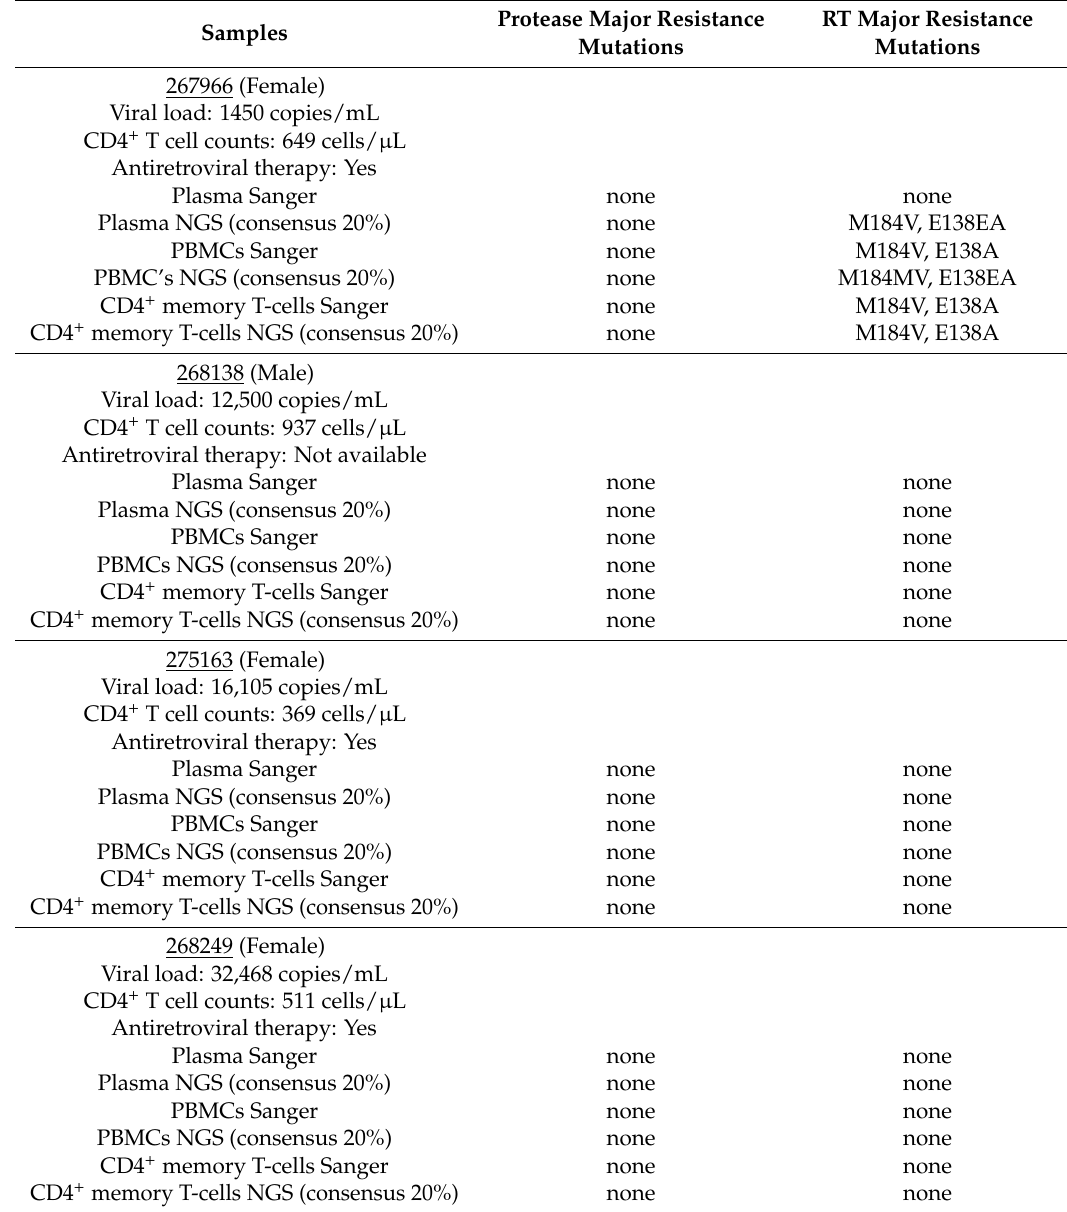
Table 2. Summary of sample viral load, CD4 + T-cell counts and the mutations detected by Sanger sequencing and Next-Generation Sequencing. High correlation between Sanger sequencing and NGS-based HIV assay (consensus 20%) was observed in major resistance mutations